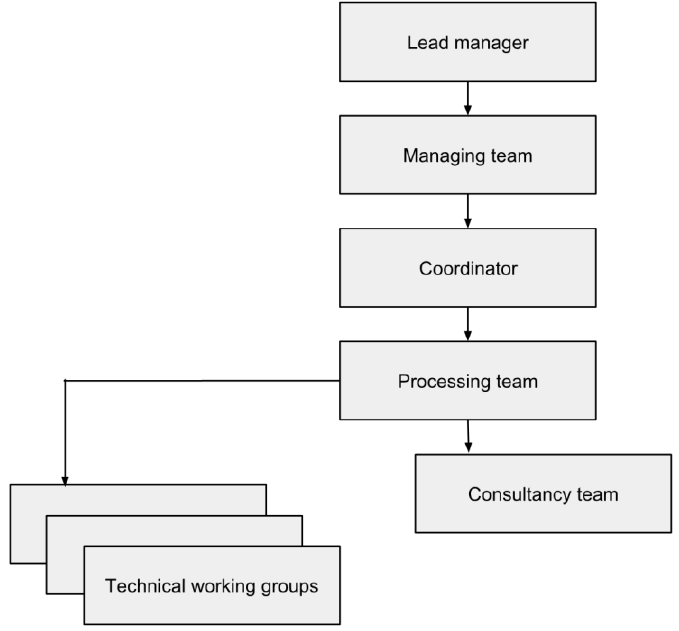
Figure 1. The organizational schema for the preparation of the GeoInfoStrategy and the GeoInfoStrategy Action Plan.